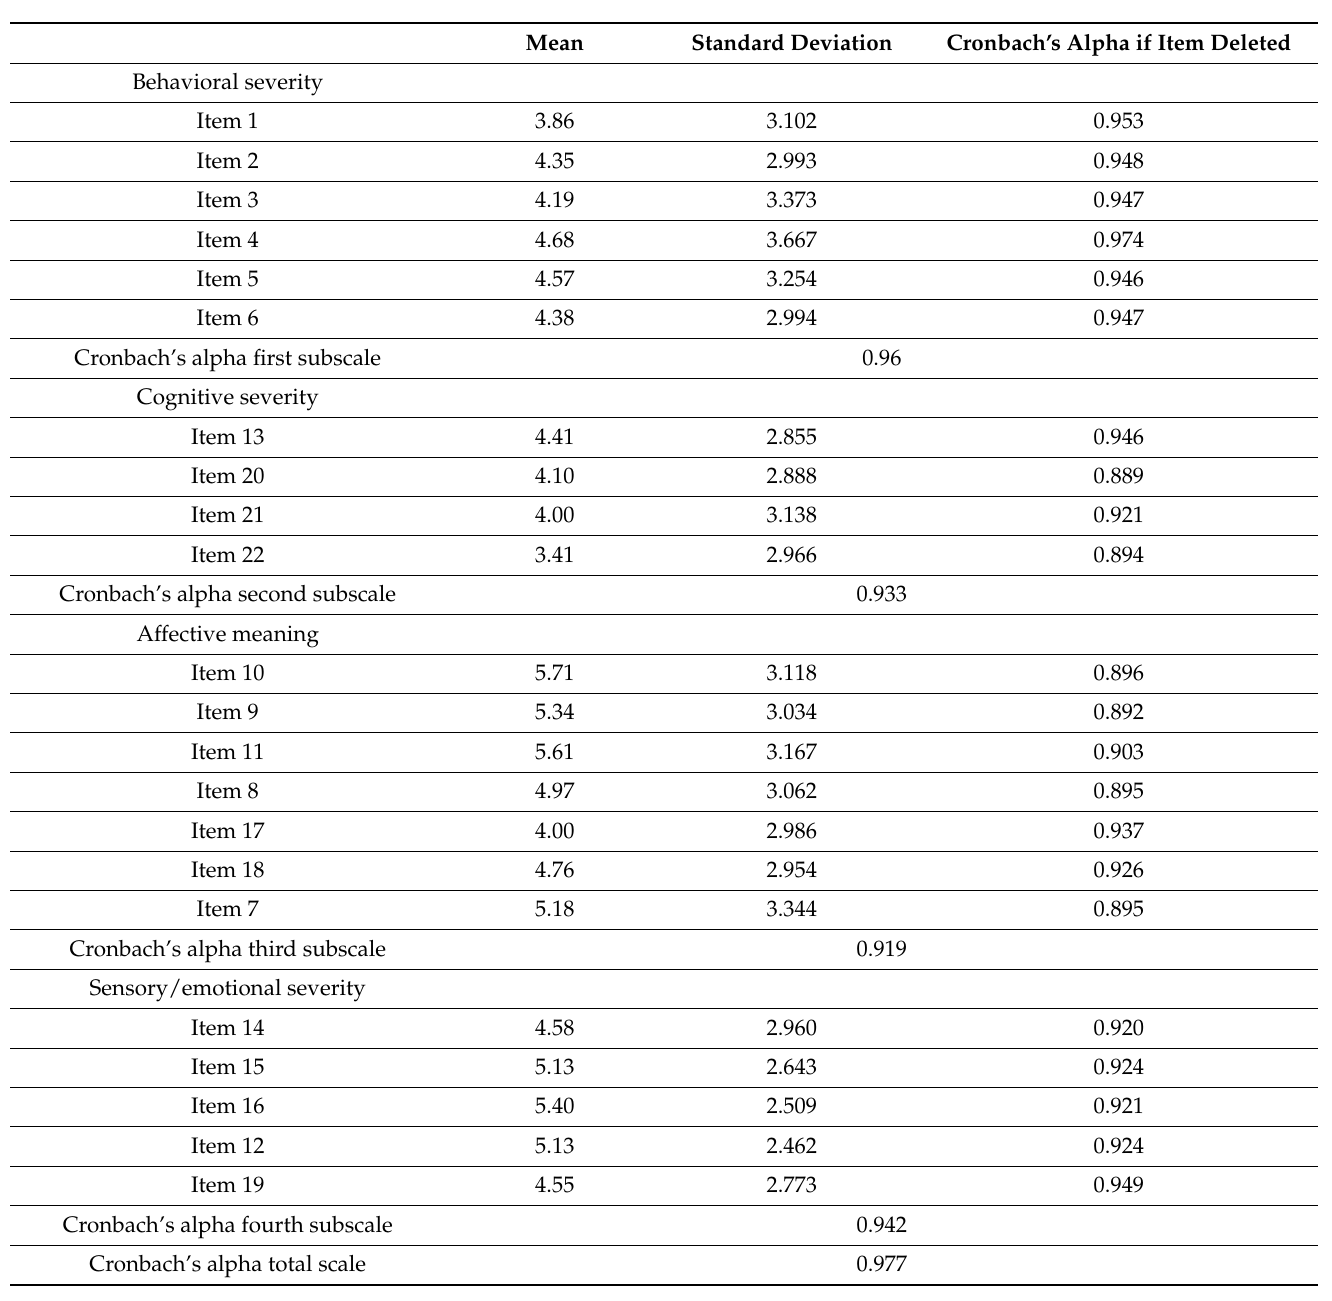
Table 2. Internal consistency: Cronbach’s alpha for the subscales and with items